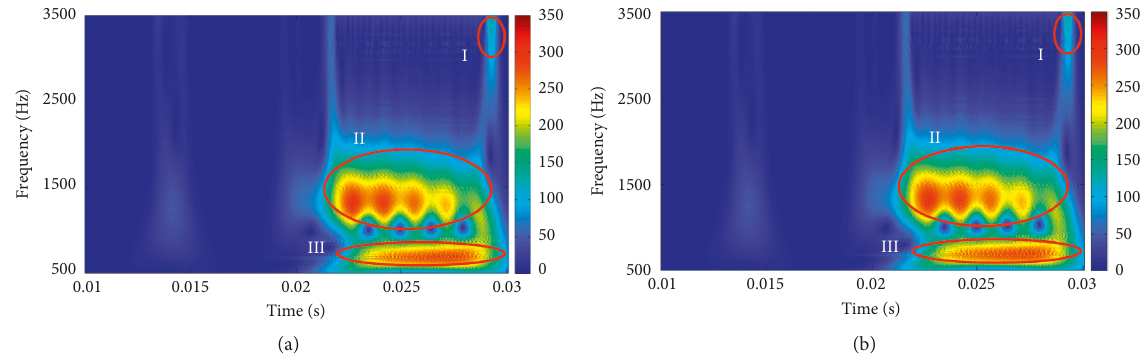
Figure 17: Time-frequency distribution spectrogram of axle box acceleration: (a) hardening material; (b) nonhardening